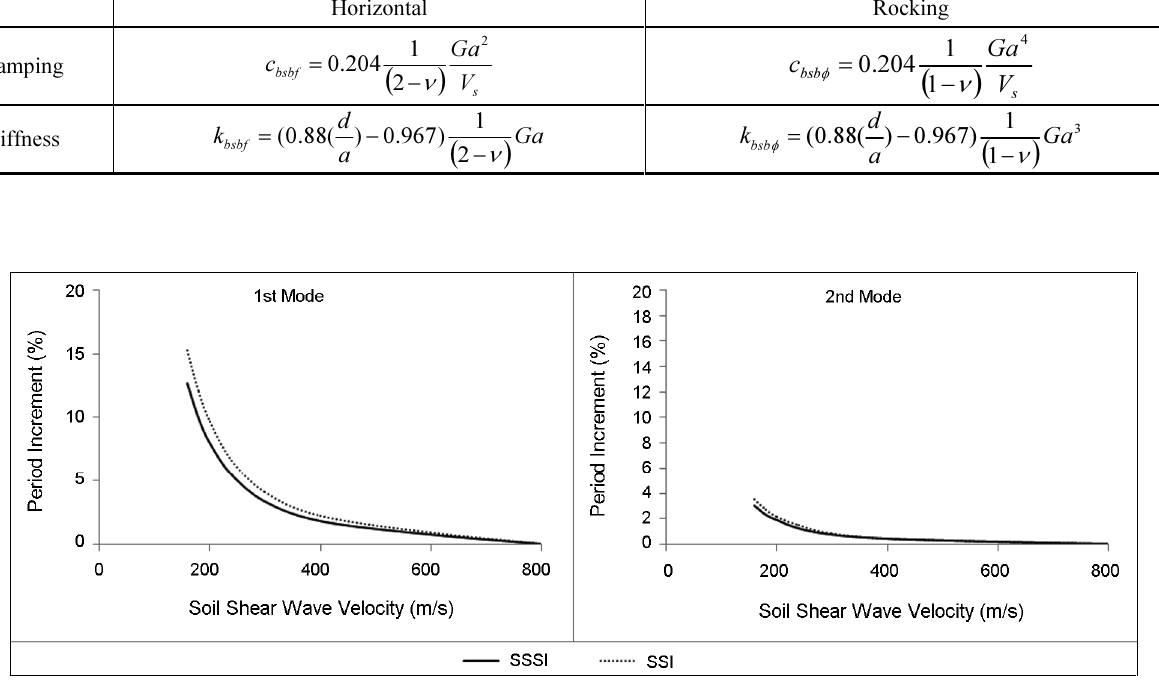
Table 2. Values for SSSI parameters ( damping